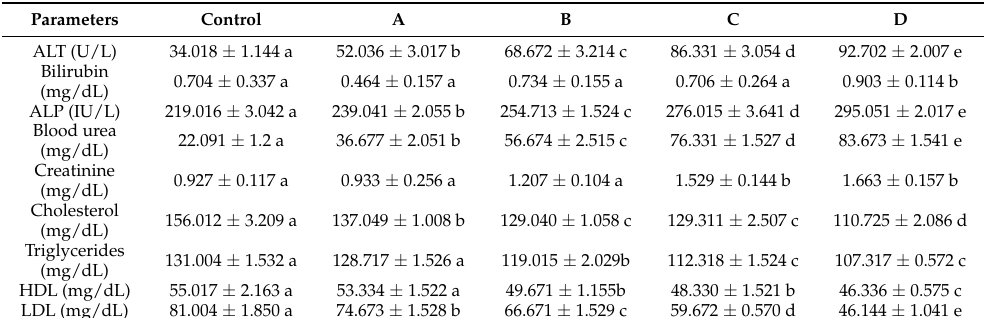
Table 4. Blood biochemical parameters of control and groups fed with flower methanolic extract of P. hysterophorus